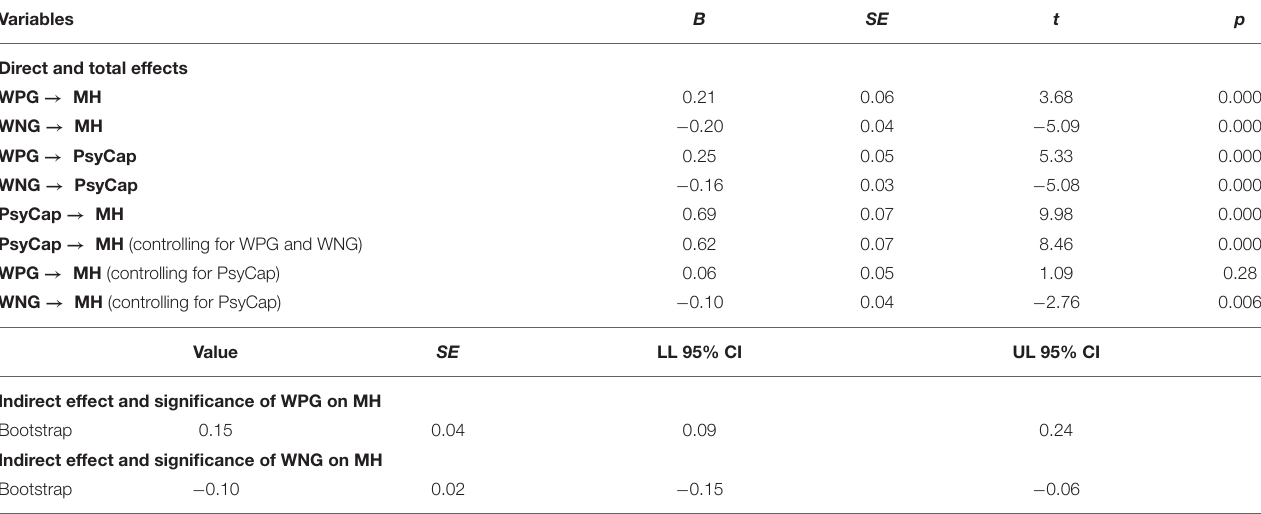
TABLE 3 | Regression results for simple mediation ( N = 222). Variables B